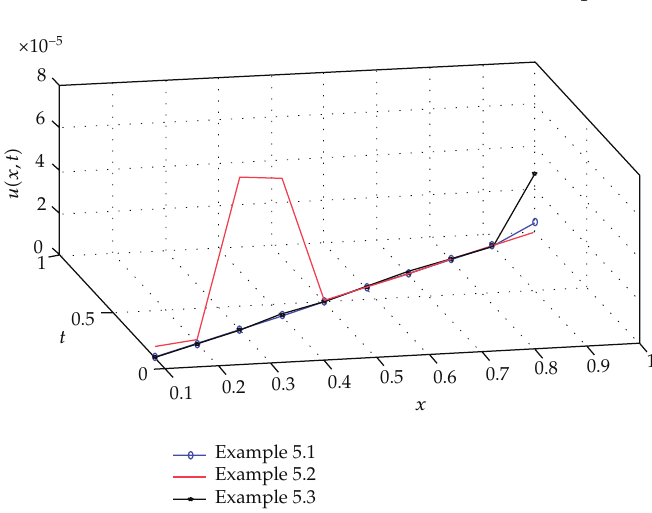
Figure 11: The compared results of the relative errors for Examples